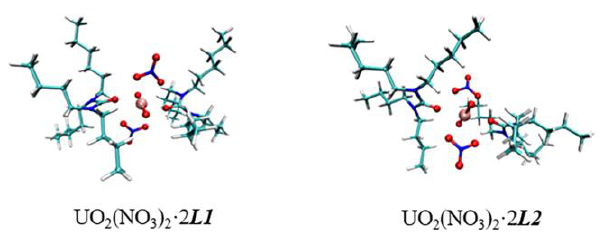
Figure 8. Optimized geometries of free L and U- L complexes.